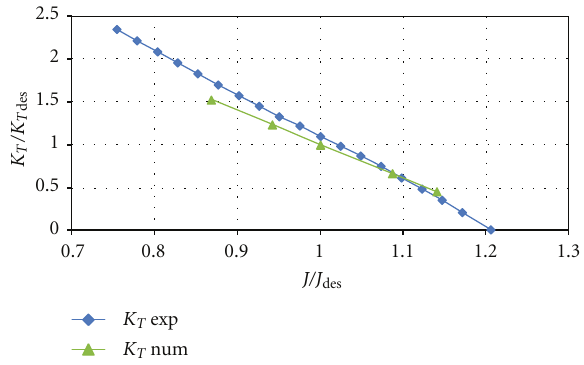
Figure 11: Comparison between numerical and experimental total thrust coe ffi cients of a CRP set designed with the proposed